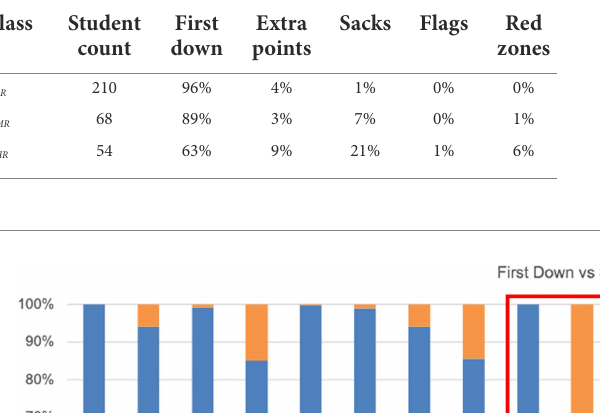
TABLE 4 Average features per class after applying final classifier to students in a validation set.